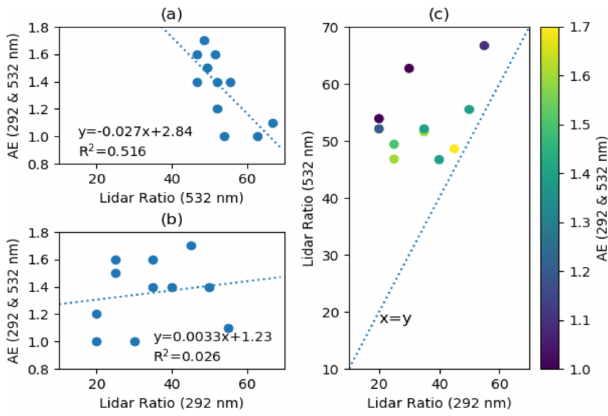
Figure 5. The S 1 values for 292 and 532nm as well as the AE (292 and 532nm) according to Table 1: (a) 532nm S 1 and AE (292 and 532nm) and (b) 292nm S 1 and AE (292 and 532). (c) Scatterplot of the S 1 values for 532 and 292nm with the color bar showing the AE (292 and